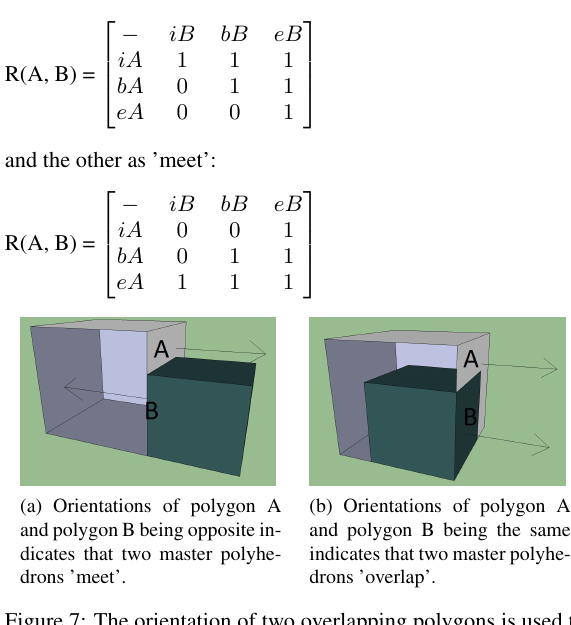
Figure 7: The orientation of two overlapping polygons is used to tell relationships of their master polyhedrons.